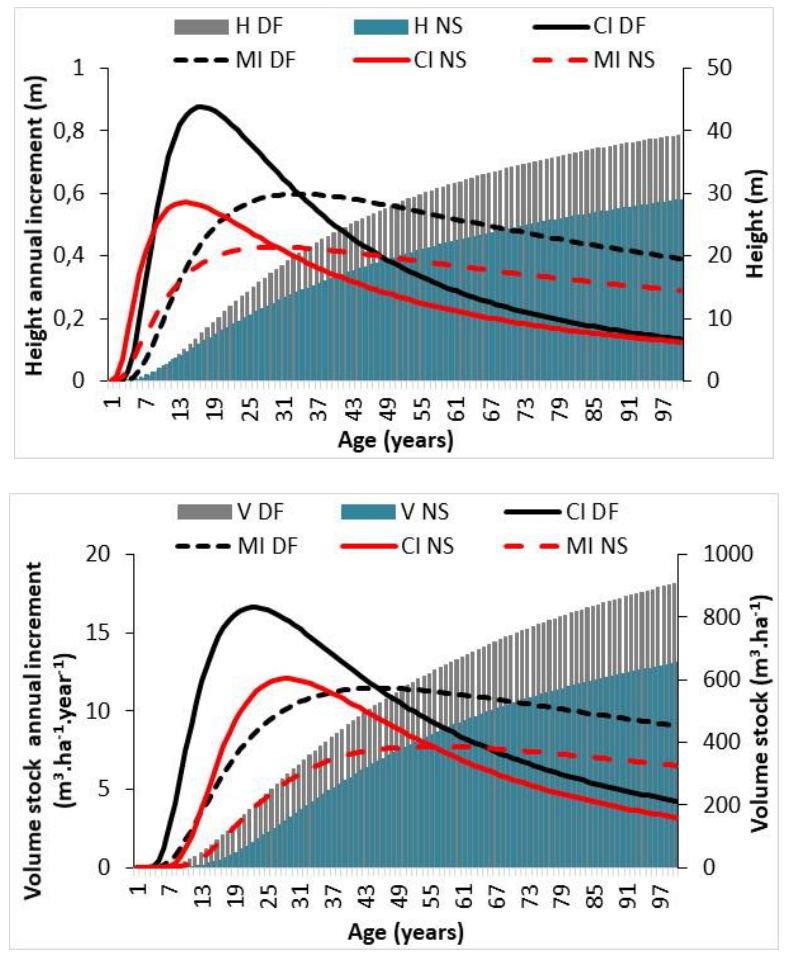
Figure 2. Courses of current (CI) and mean increment (MI) of height (H) and volume stock (V) of Douglas fir (DF) and Norway spruce (NS) at water-affected sites at UFE Kostelec nad Černými lesy, modelled by Korf’s function. Table 2. Parameters of Korf’s growth model for height (h) and volume stock.